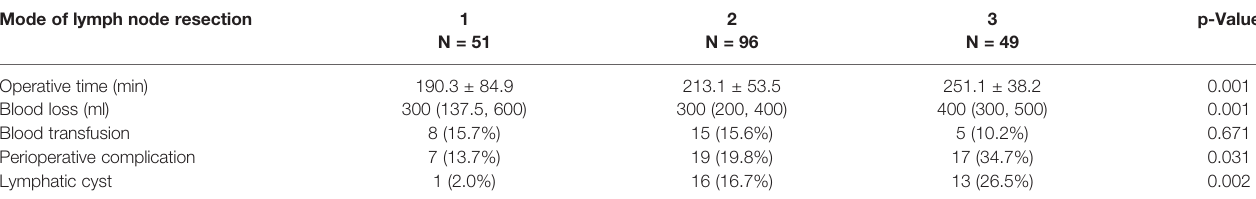
TABLE 3 | Comparison of operative time, blood loss, blood transfusion, and perioperative complications among different lymph node resection methods. Mode of lymph node resection